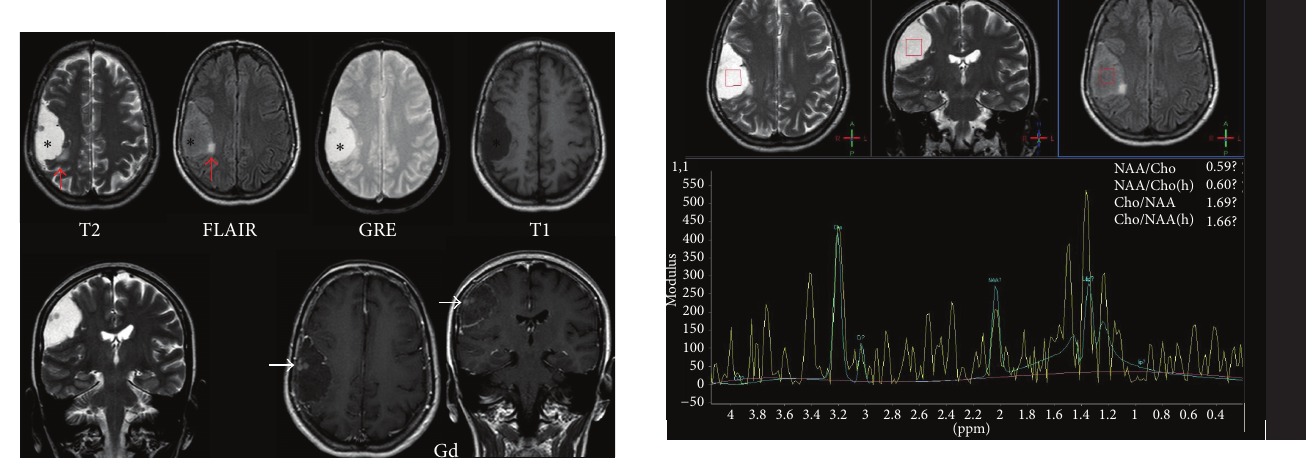
Figure 4: Spectroscopy. Increase in choline peak, decrease in NAA and creatine peaks, and increase in lactic and alanine peaks are